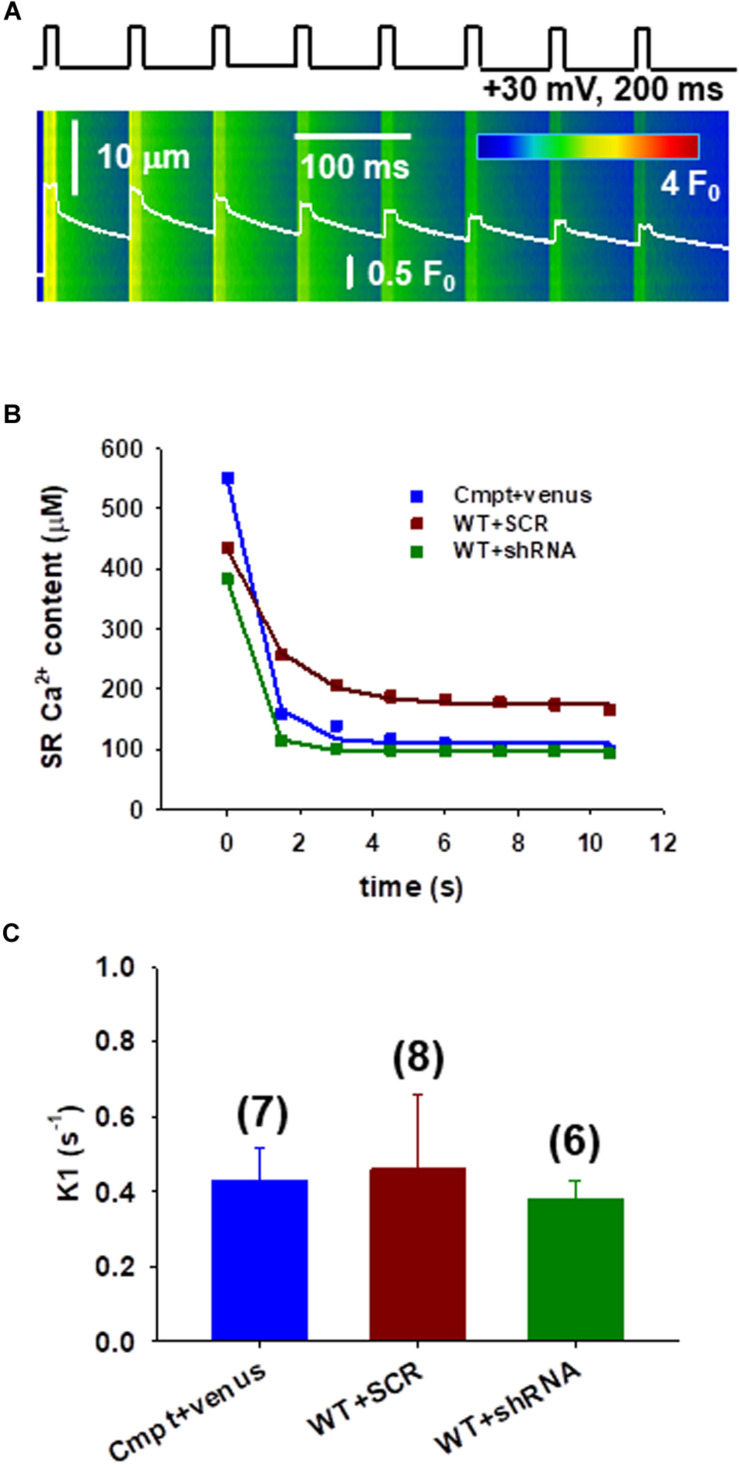
Assessing the calcium fluxes of individual FDB fibers following Orai1 manipulation. (A) Line-scan image of the kinetic analysis of Ca2+-release fluxes for transients elicited by a train of depolarizing pulses to +30 mV at 1 Hz frequency, lasting 200 ms each in Cmpt FDB fibers reconstructed with venus-Orai1. The white trace depicts the spatially averaged F(t)/F0. (B) The SR Ca2+ content was estimated from the amount released minus the removal flux. A single-exponential function was fitted to the points (for further details please see Eq. A10 in Appendix A from Sztretye et al., 2017). Note that there is a sharp decrease of the SR calcium content following the first depolarizing pulse. (C) Pooled data of the calculated fluxes (K1) through Orai1 channels as predicted by our model (see Appendix A from Sztretye et al., 2017). Reconstructing the mutant fibers with venus-Orai1 restored the Ca2+ fluxes to the levels previously seen in WT fibers (consult Sztretye et al., 2017, Figure 4F). The numbers in parenthesis denote the number of cells studied.